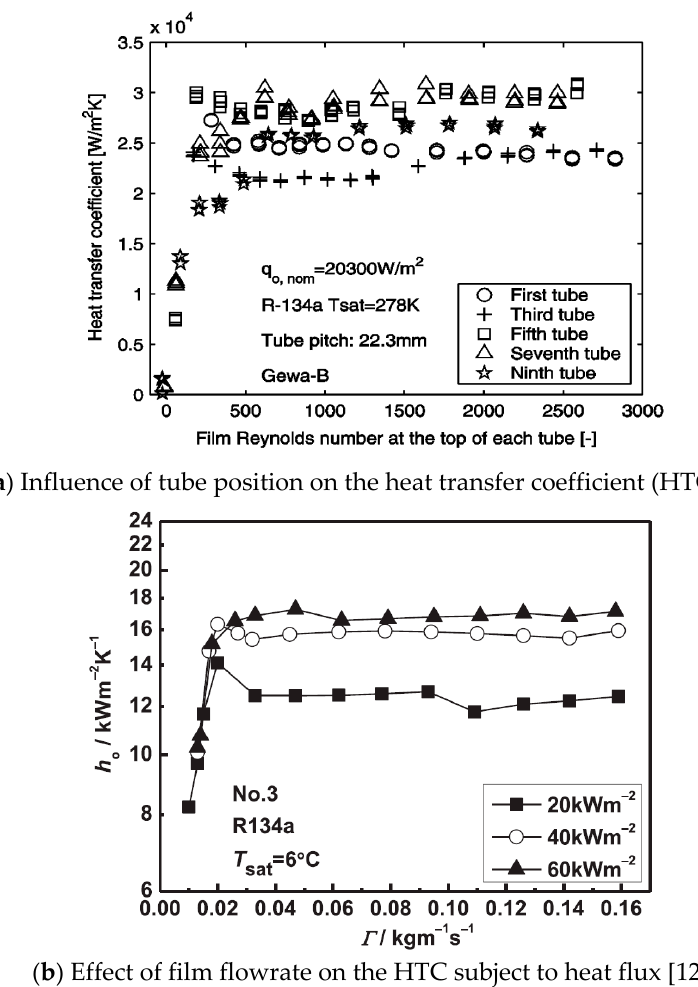
Figure 4. Trend of HTCs subject to tube position and heat flux for the falling film evaporator with R-134a. Figure 4a Reprinted with permission from [8]. Copyright 2007 Taylor and Francis; Figure 4b Reprinted with permission from [12]. Copyright 2017 Elsevier .